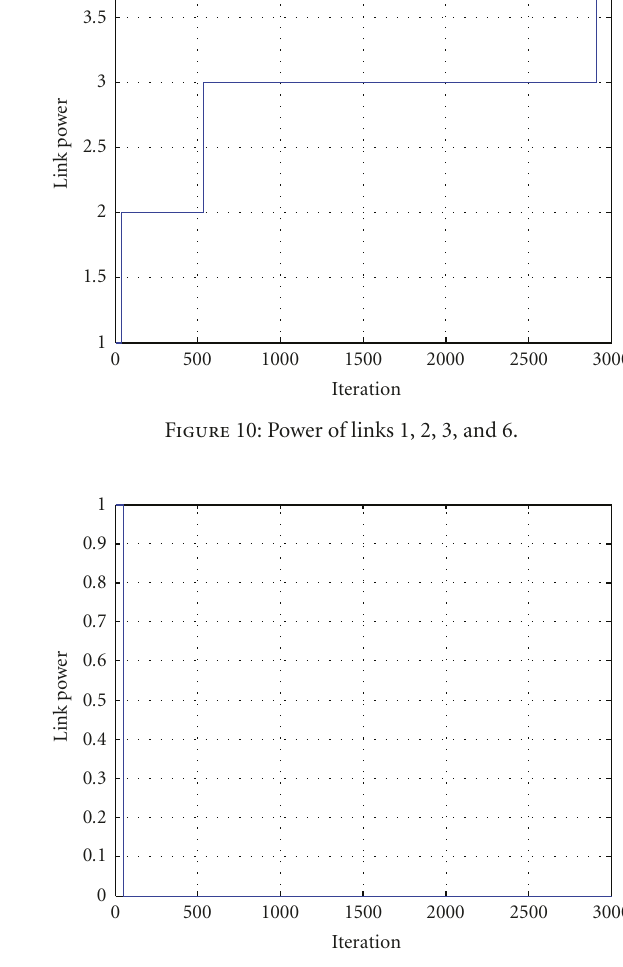
Figure 11: Power of links 4, 5, 7, 8, and